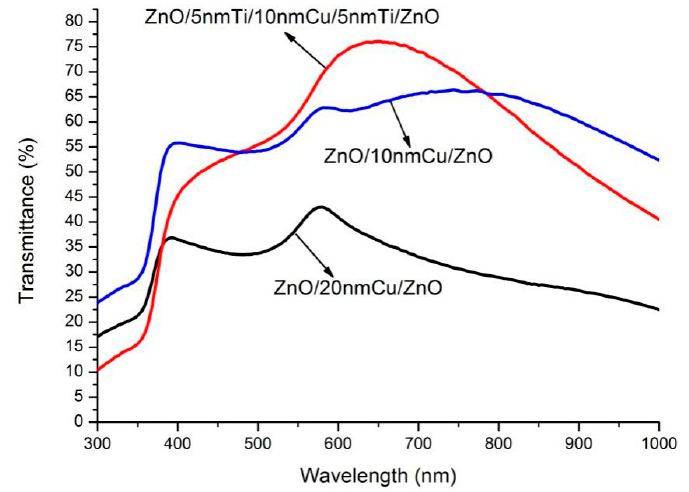
. Figure 1. The optical transmission spectra of three unannealed ZnO transparent conductive thin-film Figure 1. The optical transmission spectra of three unannealed ZnO transparent conductive thin- systems. film systems. Table 2. Sheet resistance and figure of merit of the three ZnO transparent conductive thin films. Table 1. The refractive index and extinction coefficient of ZnO, Cu and Ti at different wavelengths [24]. Figure Sheet Resistance ( Ω /sq) Figure of